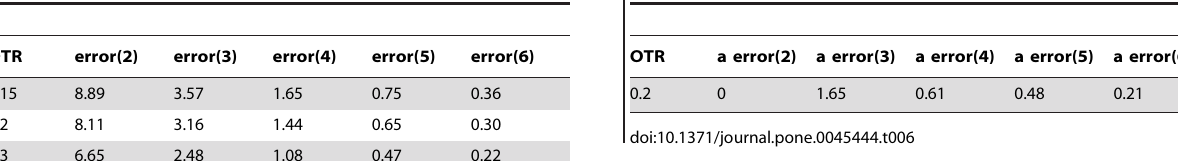
Table 6. Additional error due to asymmetry in percentage for the effective resistance of